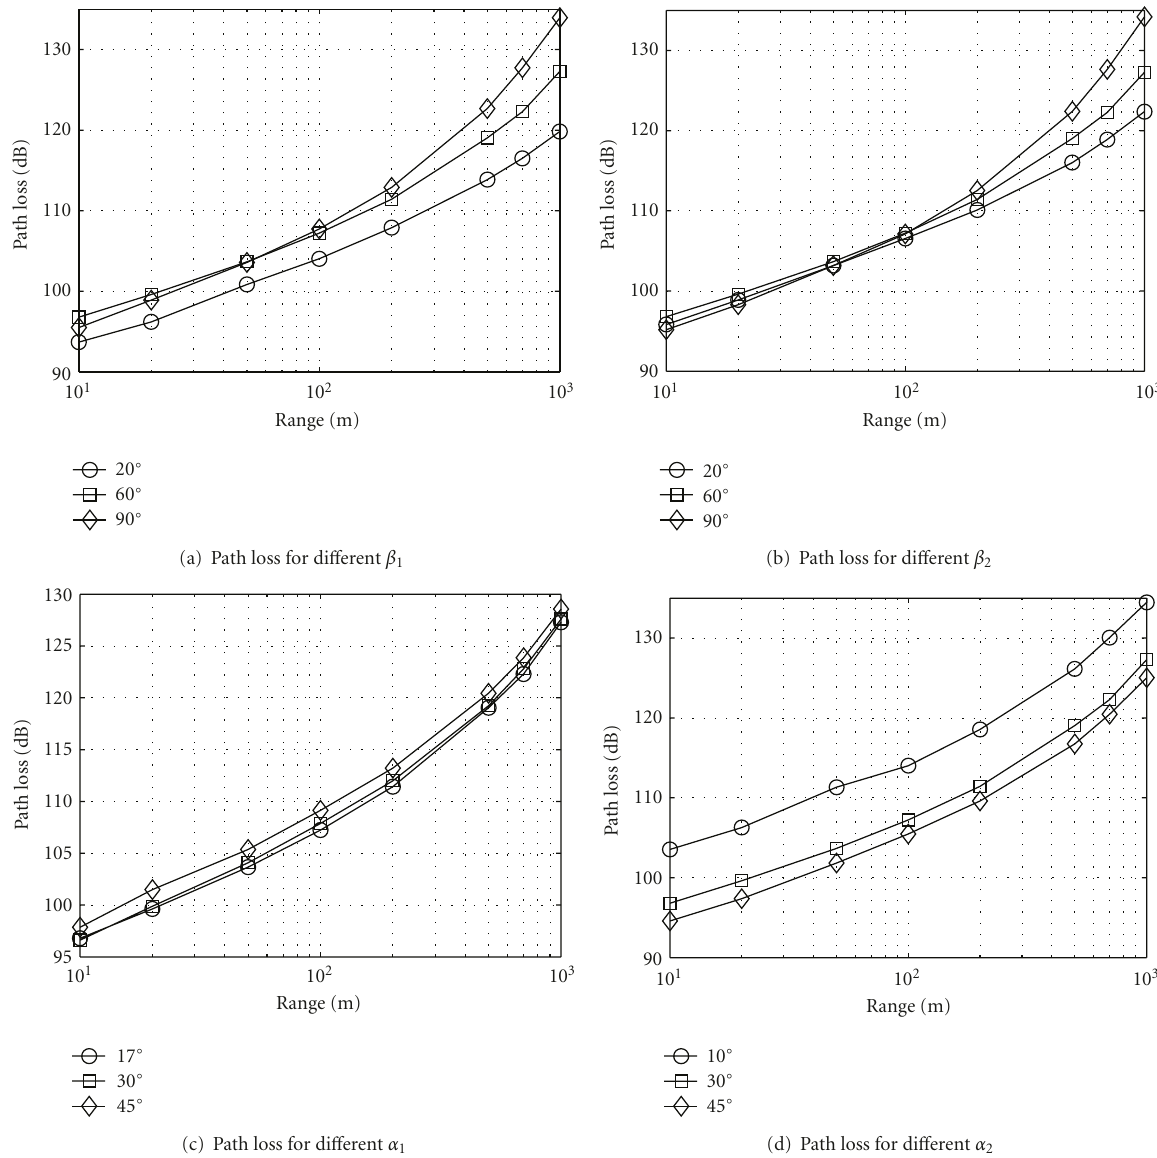
Figure 6: Predicted path loss for di ff erent system